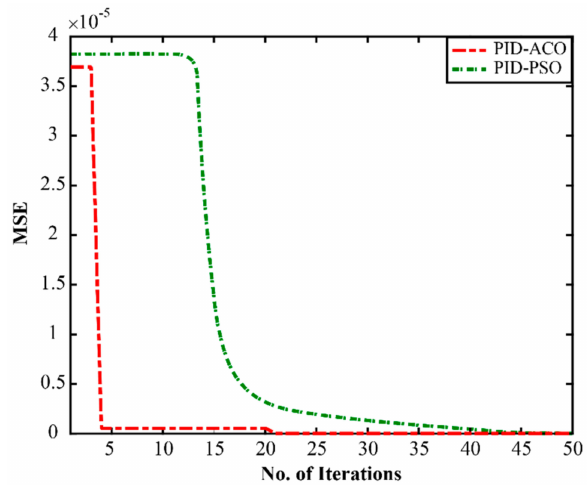
Figure 13. Convergence curve of ACO and